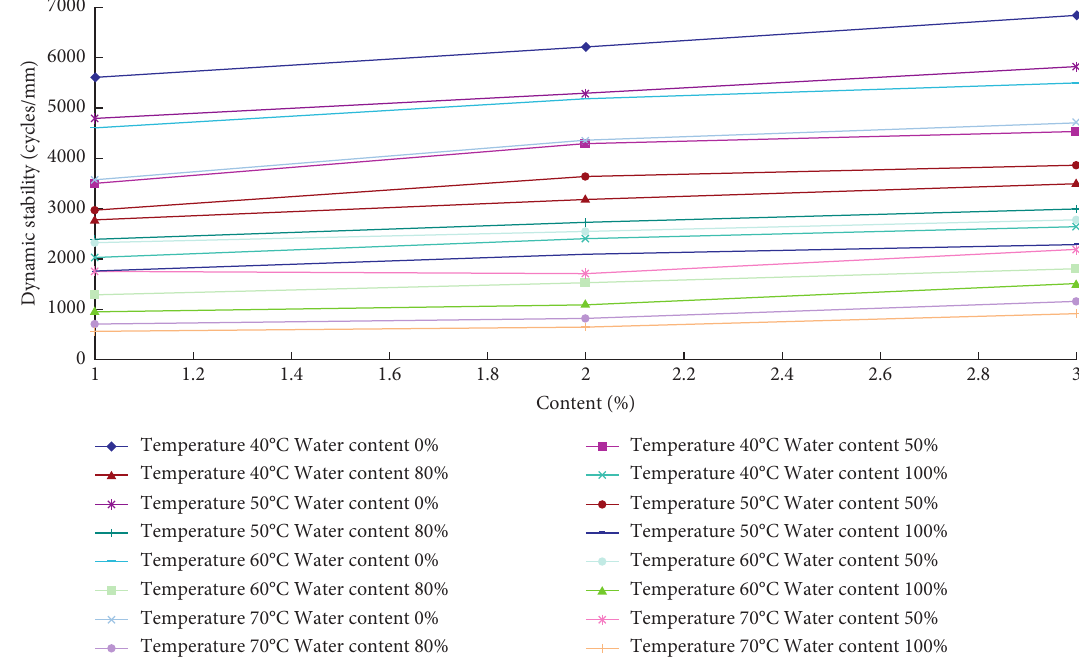
Figure 5: Effect of content on dynamic stability.